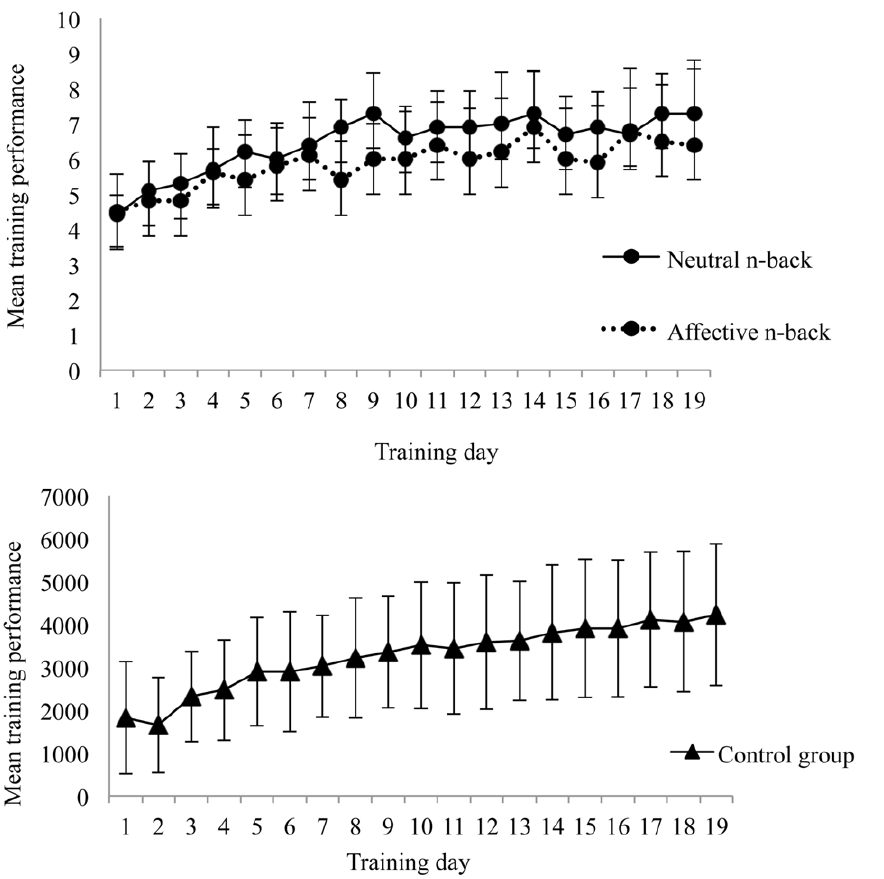
Figure 2. Performance improvement across training days. These two graphs show the linear improvement in average training performance across training days for all three groups. For the neutral n -back and affective n -back the score refers to mean level of n -back achieved. The score on the feature match task for the control group constitutes a mean composite score (see Methods and Materials).